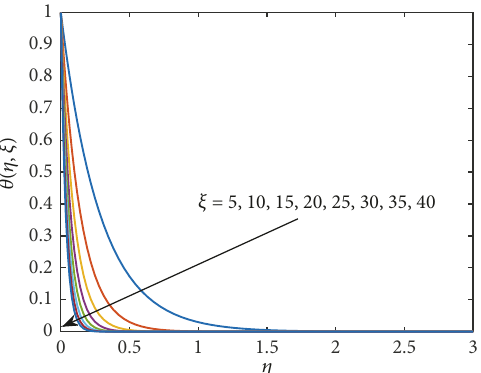
Figure 2: Temperature profiles at different values of 𝜉 with 𝑃𝑟 = 0.7 , 𝑛 = 1/2 , and 𝑧 = 40 .